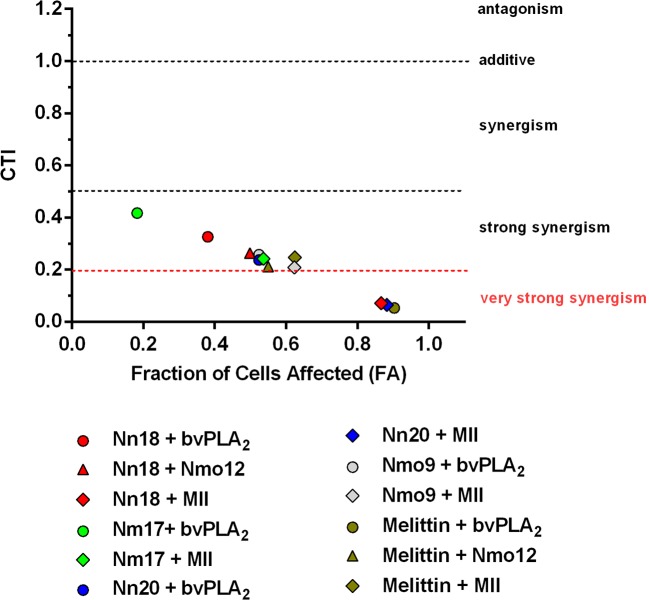
Combination effect of cytotoxins and PLA2s. The Combination of Toxin Index (CTI) was calculated for 12 different combinations of melittin/cytotoxins and PLA2s. The X axis shows the level of cytotoxicity, where 0 = 100% of viable cells, and 1 = 0% of viable cells. The Y axis shows the CTI values, where values <1, =1, or >1 indicate that the toxins act synergistically, additively, or antagonistically, respectively. CTI <0.5 indicates strong synergism, and CTI <0.2 very strong synergism. Triangles, diamonds, and circles represent melittin/cytotoxin combinations with PLA2s from group I (Nmo12), II (MII), and III (bvPLA2), respectively.